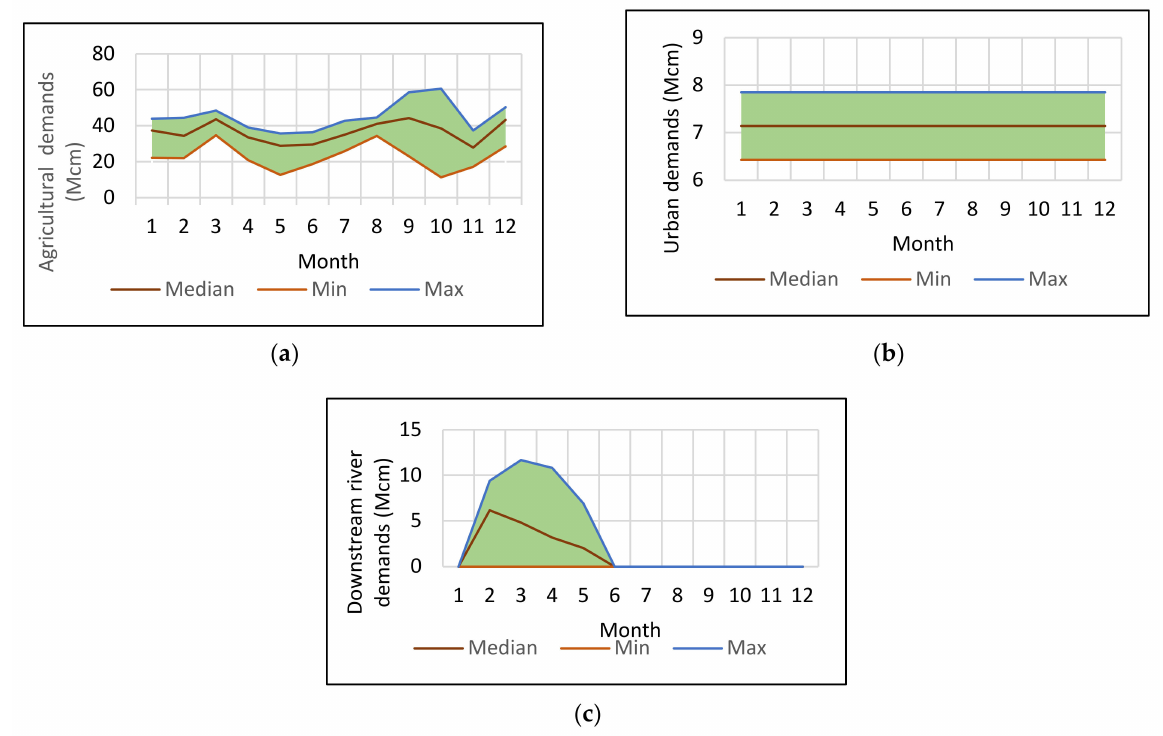
Figure 5. Historical water demand distributions from agriculture ( a ), urban use ( b ) and downstream river ( c